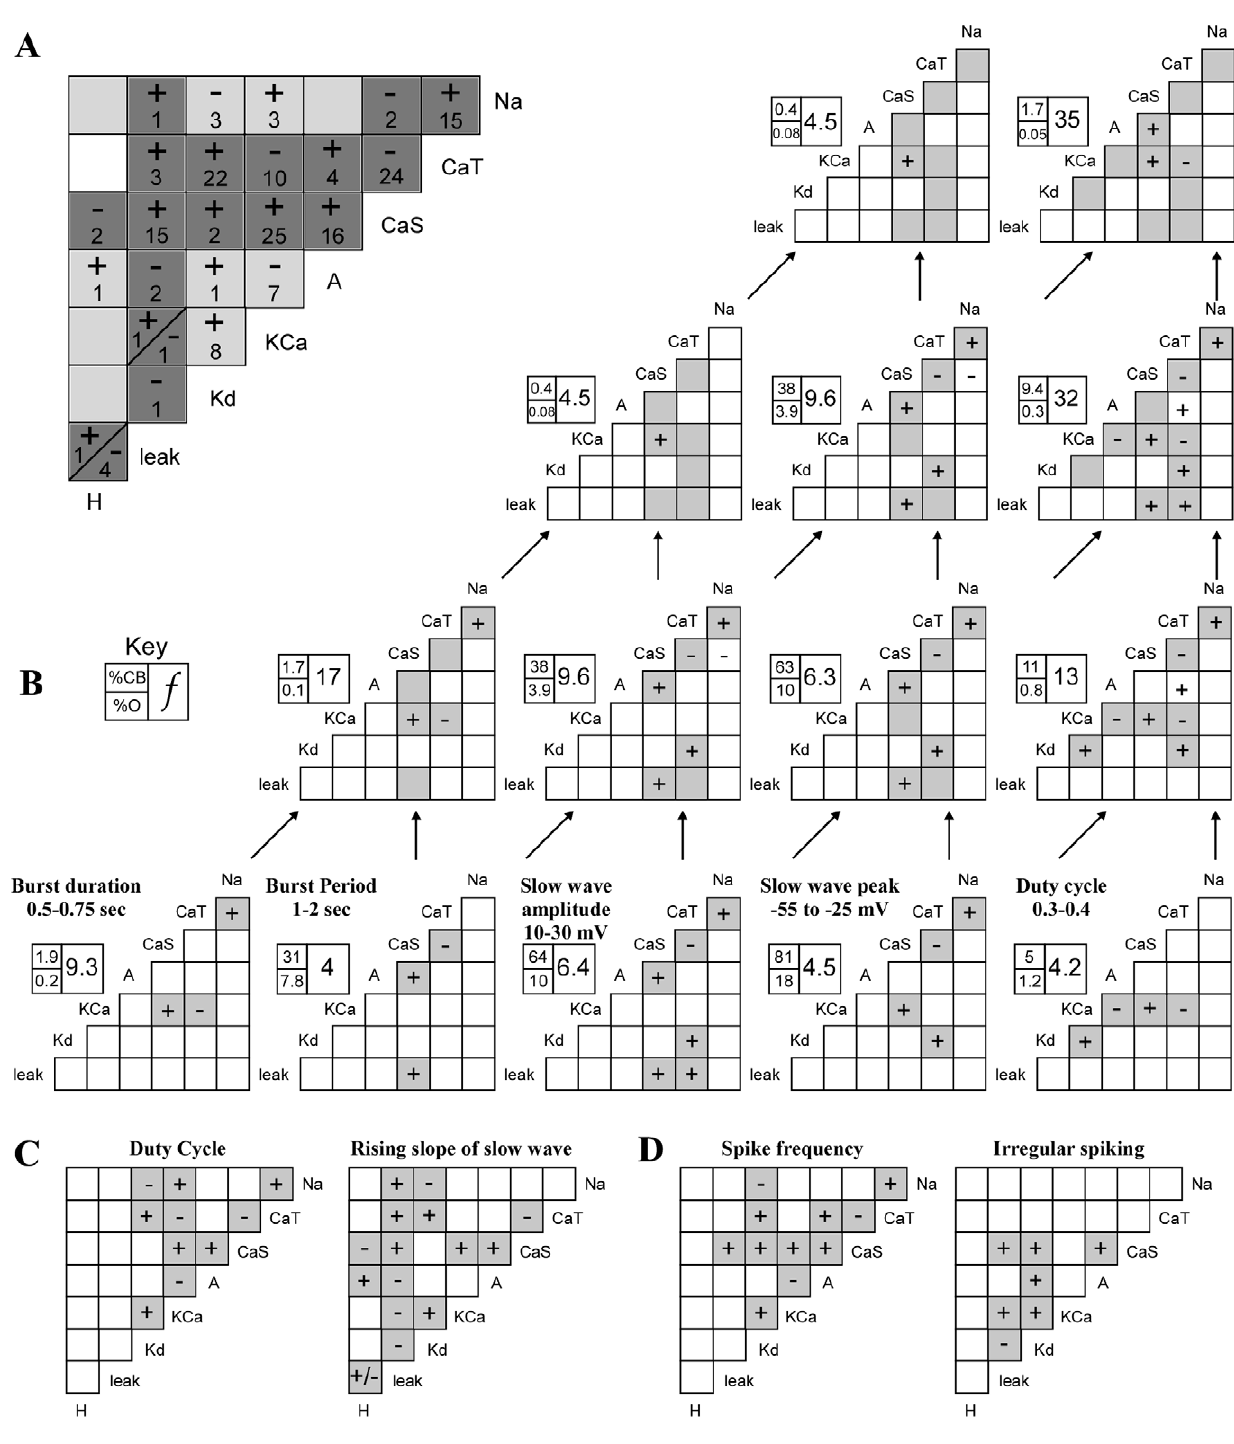
Figure 6. Each activity type utilizes a unique combination of conductance correlations. For all plots, a plus sign ( + ) indicates that a linear relationship with a positive slope was found for this conductance pair. Likewise, a minus sign ( 2 ) indicates a linear relationship with a negative slope. (A) Summary of entire database. If a correlation was seen, in any activity subsection investigated, it is included here. Conductance pairs shown in dark grey are those that have not yet been observed experimentally, whereas those highlighted with light grey have been found in experiments on STG neurons [8,9]. Two negative relationships reported here (g Na vs. g Kd and g A vs. g KCa ) were found to be positive relationships when investigated experimentally by Schulz et al [9]. However, there is also agreement with experimental results, such as a positive correlation (g A vs. g H ) found by Khorkova and Golowasch [8]. Numbers indicate how many activity types showed a particular conductance correlation. (B) Example of how restricting multiple aspects of activity type may influence the appearance of correlations. The bottom row shows correlations for populations based solely on one of the previously published pacemaker criteria [28]. Arrows indicate populations based on combinations of these criteria. Shading here is used only to show that a correlation was present in a ‘‘parent’’ population; if a plus or minus sign is absent then no correlation was observed. %CB is %Success for a correlation-based population, %O is %Success for the original database, and f is the ratio of the two, or f Success . See Methods.